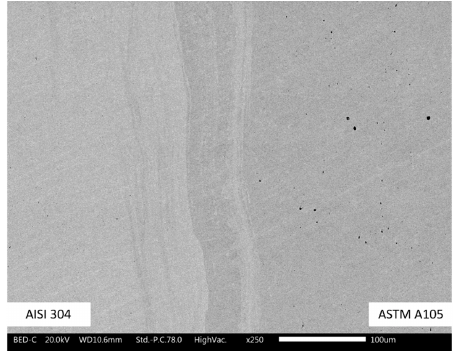
Figure 3. Scanning electron microscopy image of the welded specimen interface. Metals 2020 , 10 , x FOR PEER REVIEW